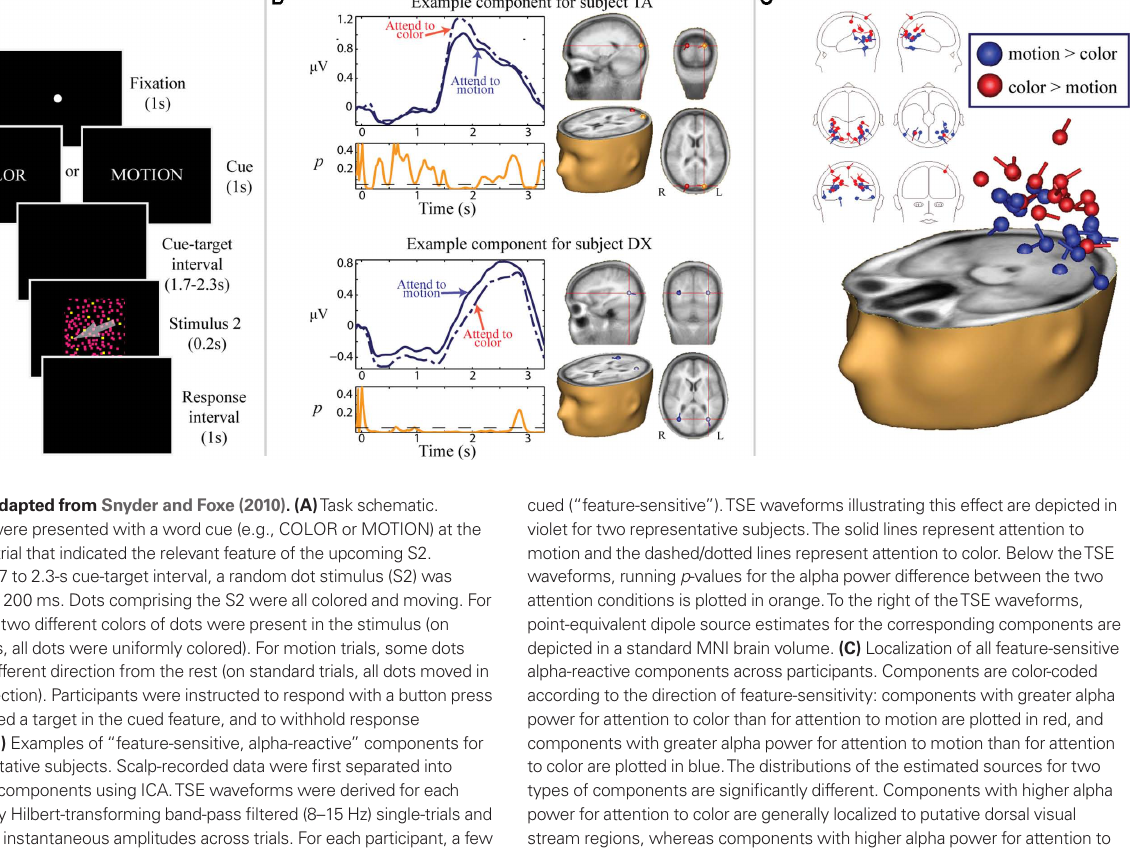
FiGurE 3 | Adapted from Snyder and Foxe (2010). (A) Task schematic. Participants were presented with a word cue (e.g., COLOR or MOTION) at the start of each trial that indicated the relevant feature of the upcoming S2. Following a 1.7 to 2.3-s cue-target interval, a random dot stimulus (S2) was presented for 200 ms. Dots comprising the S2 were all colored and moving. For color targets, two different colors of dots were present in the stimulus (on standard trials, all dots were uniformly colored). For motion trials, some dots moved in a different direction from the rest (on standard trials, all dots moved in the same direction). Participants were instructed to respond with a button press if they detected a target in the cued feature, and to withhold response otherwise. (B) Examples of “feature-sensitive, alpha-reactive” components for two representative subjects. Scalp-recorded data were first separated into independent components using ICA. TSE waveforms were derived for each component by Hilbert-transforming band-pass filtered (8–15 Hz) single-trials and averaging the instantaneous amplitudes across trials. For each participant, a few components were highly dynamic in the alpha range during the preparatory period (“alpha-reactive” components), and some of these alpha-reactive components moreover showed power differences based on which feature was